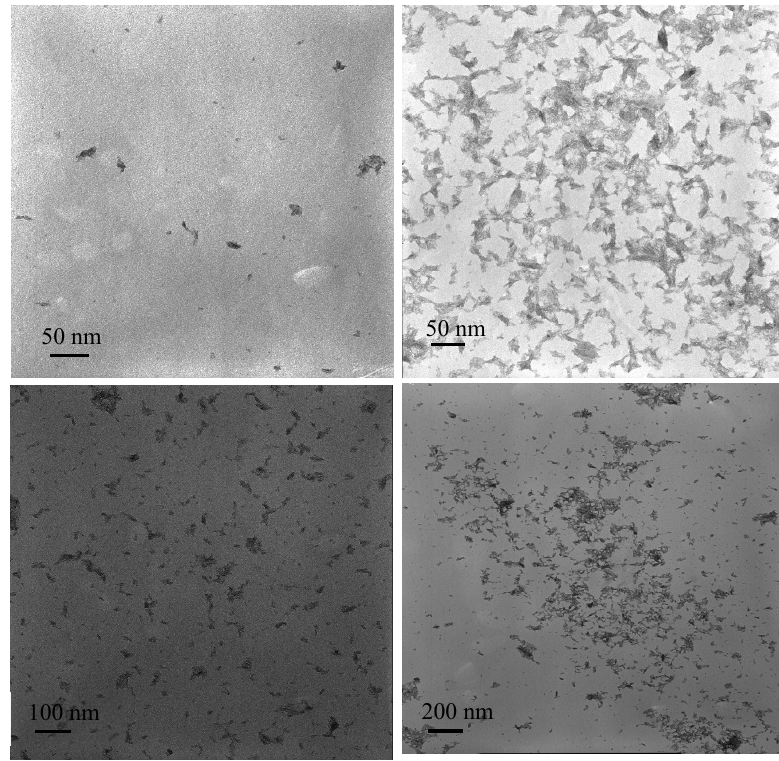
Figure 6. TEM images of TiO 2 nanoparticles.